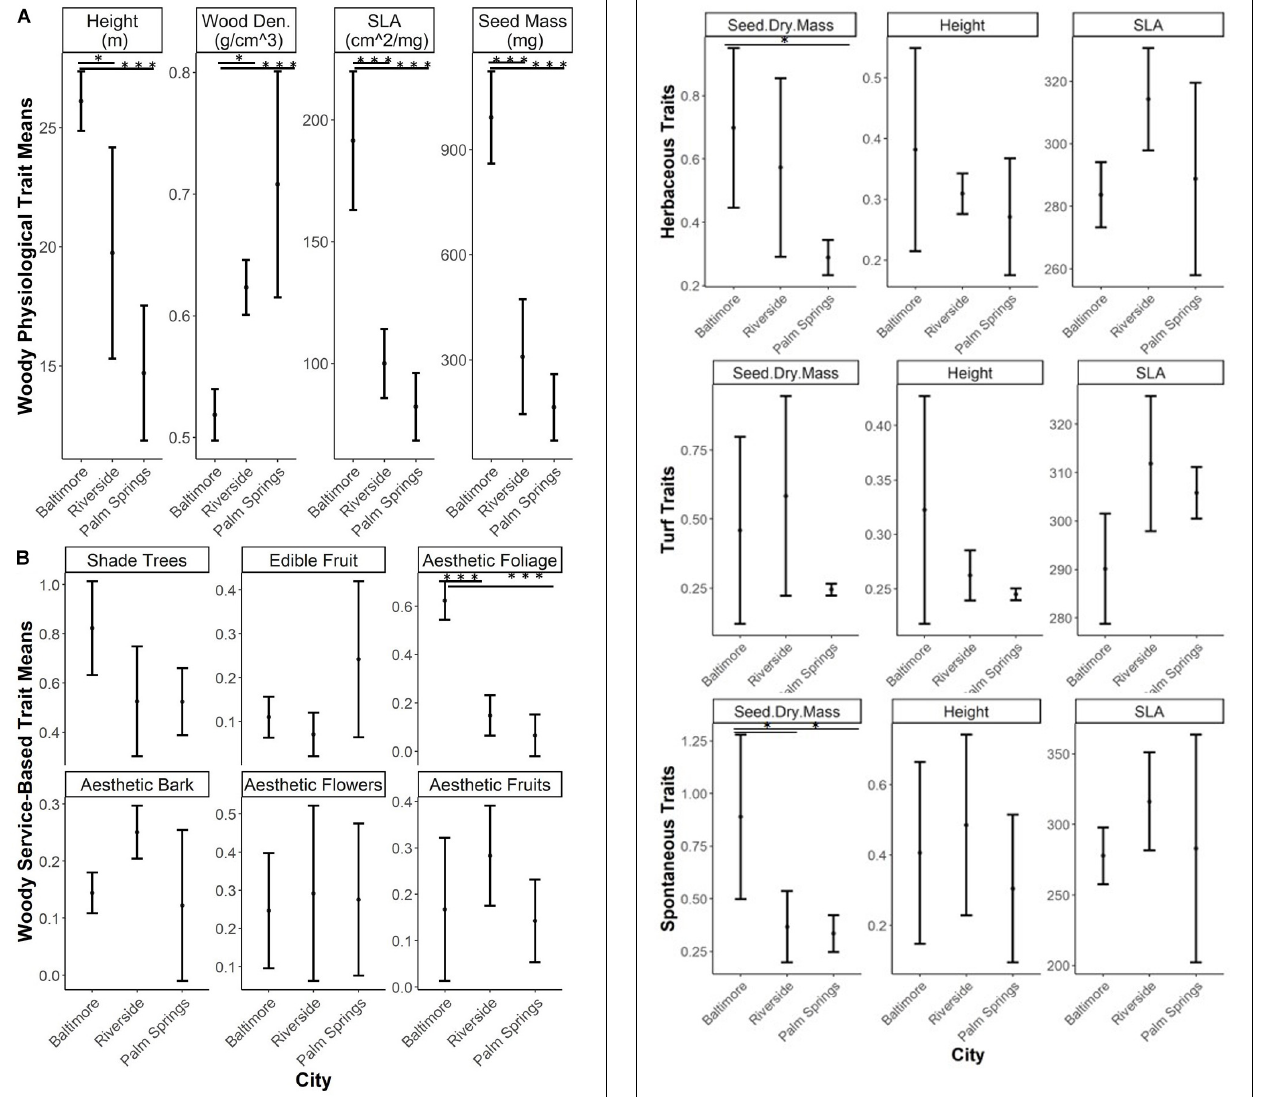
FIGURE 3 | Community weighted means (CWM) of woody functional traits (mean and standard deviation). Asterix refer to significant differences between groups tested through ANOVA with a post hoc Tukey HSD test (*0.001 < p < 0.05, *** p < 0.0001). (A) Traits related to ecophysiological characteristics; (B) Traits related to service-based functional trait characteristics.